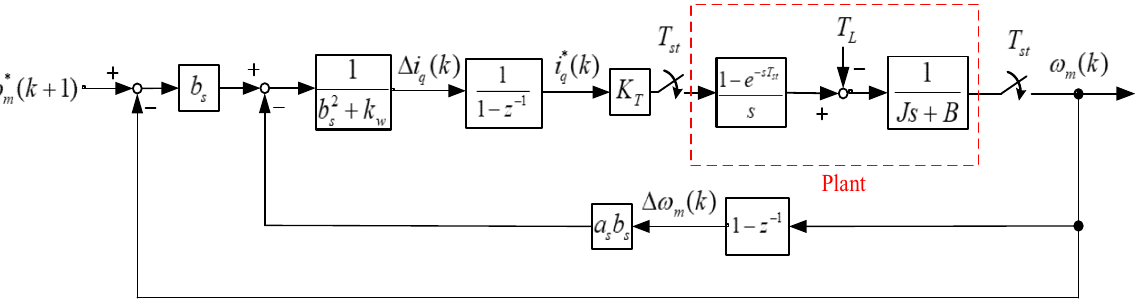
Figure 3. Block diagram of the speed-loop control.